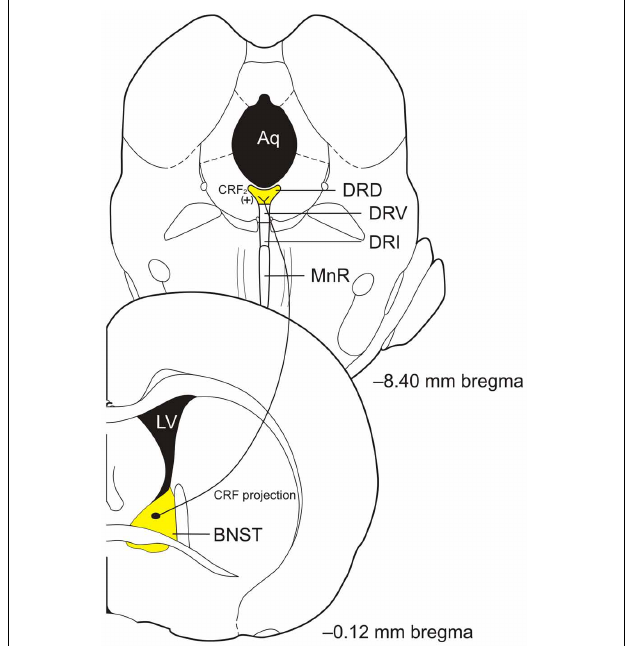
FIGURE 1 | Diagram of proposed bed nucleus of the stria terminalis (BNST) corticotropin-releasing factor (CRF) projections to the caudal portion of the dorsal part of the dorsal raphe nucleus (DRD) to activate CRF 2 receptors to modulate serotonin (5-hydroxytryptamine; 5-HT) output in control of anxiety-like behaviors. Abbreviations: Aq, aqueduct; CRF, corticotropin-releasing factor; DRD, dorsal part of the dorsal raphe nucleus; DRI, interfascicular part of the dorsal raphe nucleus; DRV, ventral part of the dorsal raphe nucleus; LV, lateral ventricle; MnR, median raphe nucleus; ( + ), excitation. Coronal section templates reproduced from Paxinos and Watson (1998), The Rat Brain in Stereotaxic Coordinates, 4th Edition. San Diego: Academic Press: 1998 with permission from